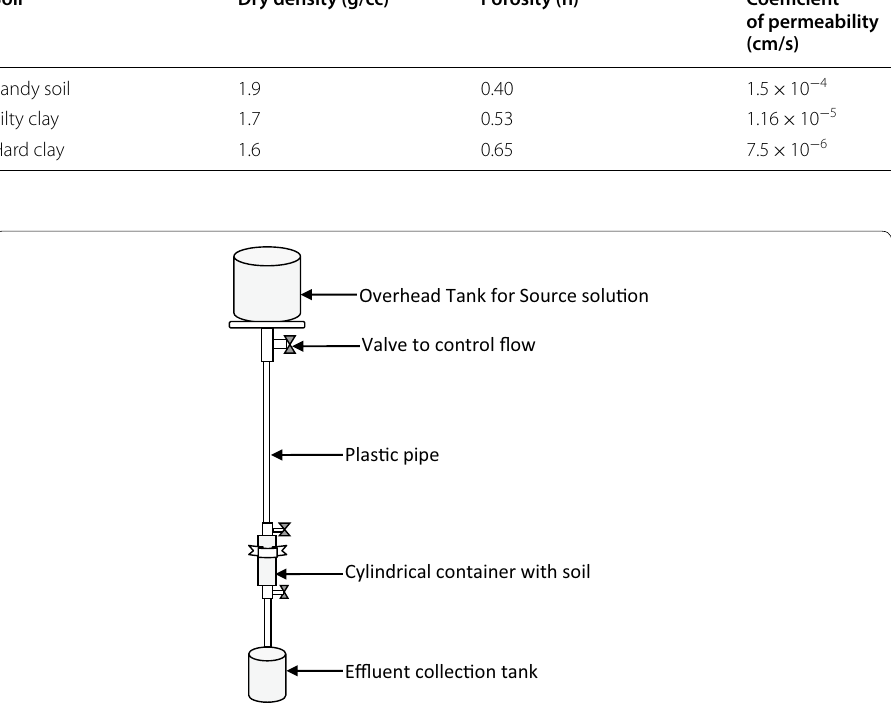
Fig. 4 Schematic diagram of Column test